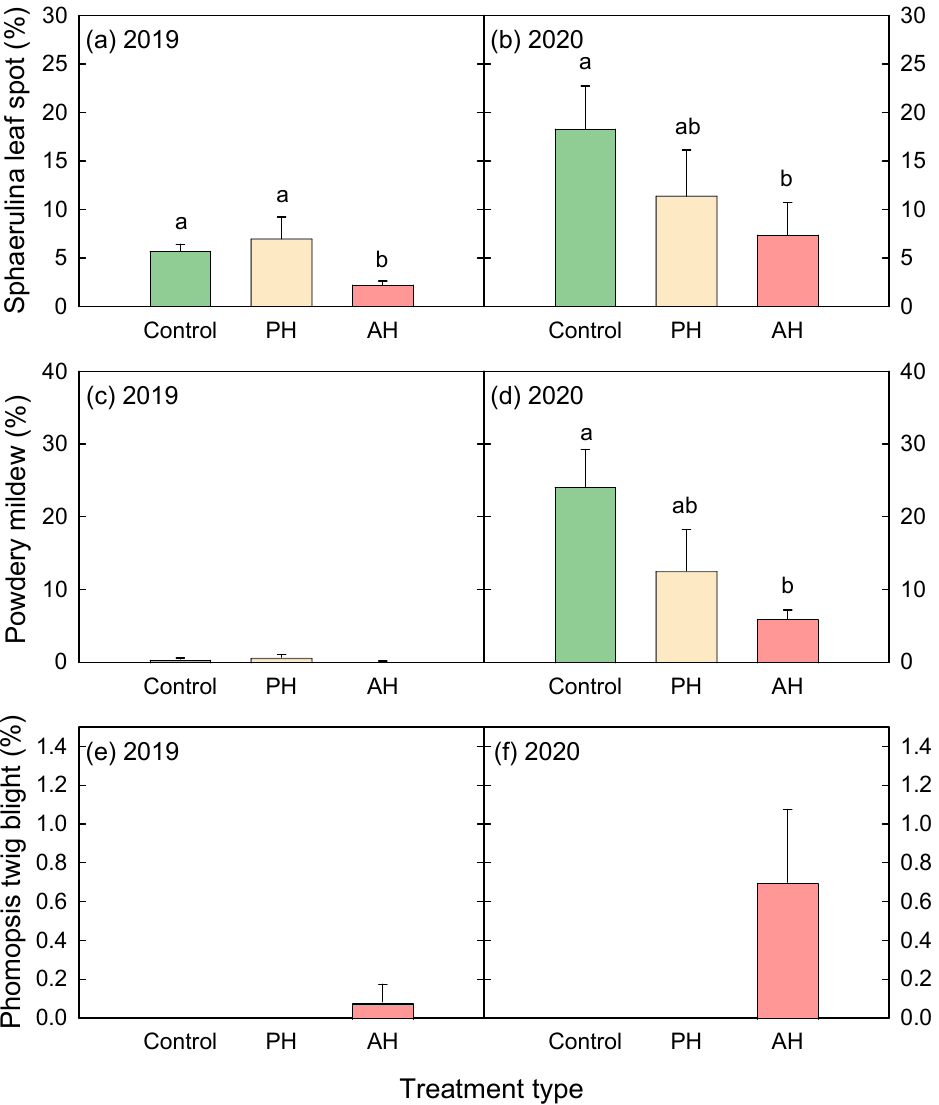
Figure 5. Warming impact on pathogen diseases. The percentage infection of Sphaerulina leaf spot disease ( a , b ), powdery mildew ( c , d ), and Phomopsis twig blight ( e , f ) of wild blueberries under different treatments in 2019 and 2020 at the end of the growing season (21 August 2019 and 28 August 2020). Different treatments are controls, active-heating (AH), and passive-heating (PH) chambers. Bars are means + SEs. The absence of letters or bars with the same letter do not differ significantly among treatments ( p > 0.05).